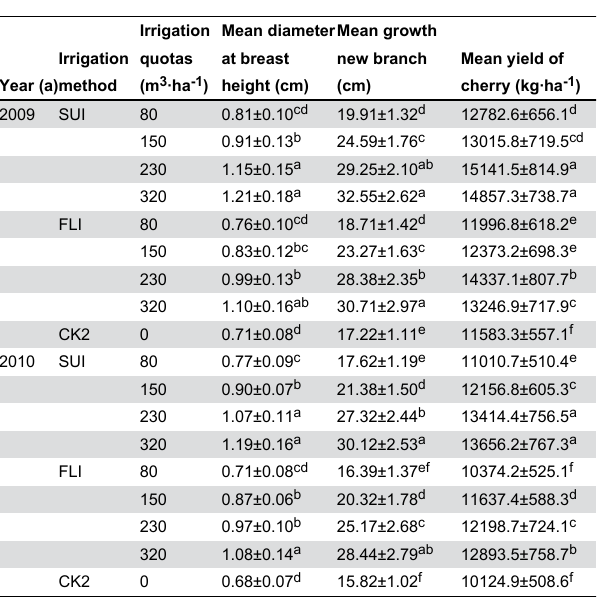
Table 5. Cherry growth conditions and yields for the different SUI and FLI quotas in 2009 and